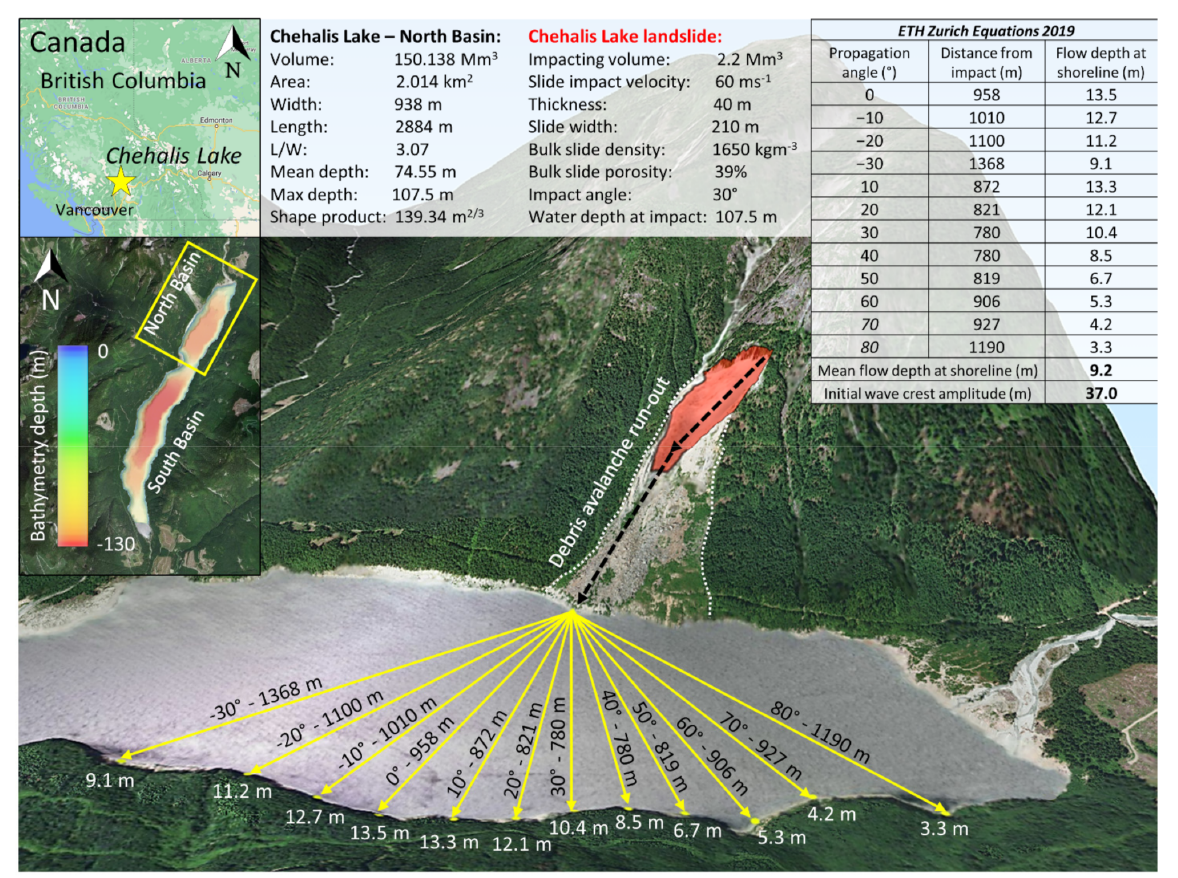
Figure 10. Chehalis Lake overview. Lake and landslide properties are shown (data from [6,7]). The distance and angle of wave propagation from the landslide impact point, which are useful inputs for the 2019 ETH-Zurich equations [46], are also shown. Flow depths at the shoreline in different locations are shown in white. Topographical background taken from Microsoft Bing Maps—2021 Microsoft Corporation Earthstar Geographics Sio (Accessed on 22 July